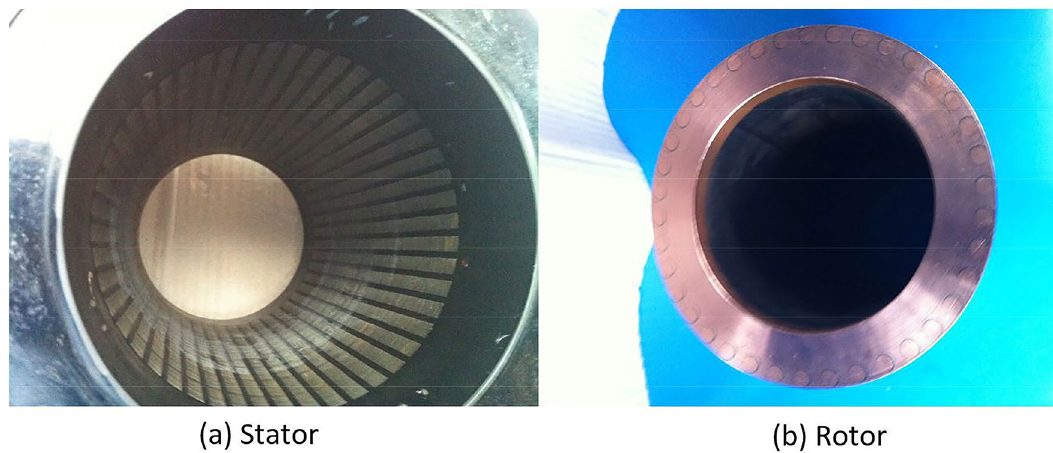
Figure 4. Assembled stator and rotor.